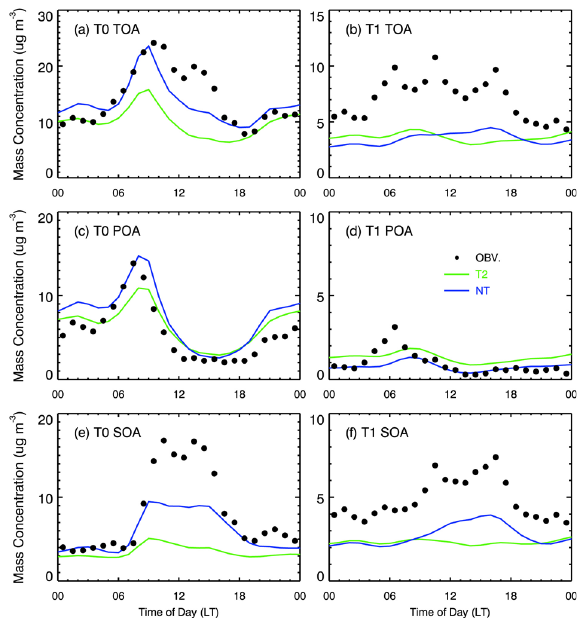
Figure 5 Fig. 5. Diurnal cycles of measured and simulated organic aerosol concentrations at T0 and T1 averaged during the period from 24 to 29 March 2006. (a) TOA at T0, (b) TOA at T1, (c) POA at T0, (d) POA at T1, (e) SOA at T0, and (f) SOA at T1. Black dots: measurements; green line: the T2-SOA model; blue line: the NT- SOA